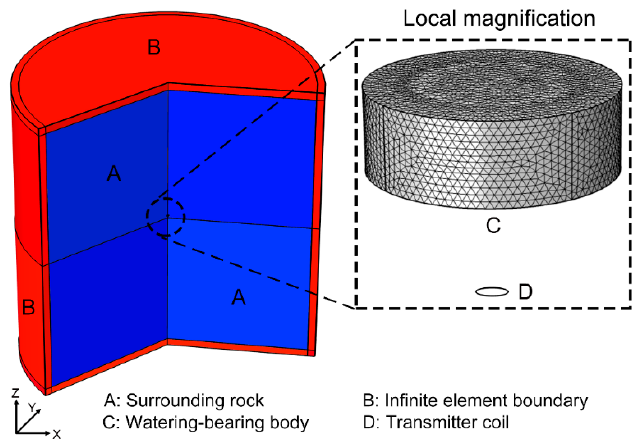
Figure 7. Layout of finite element model.